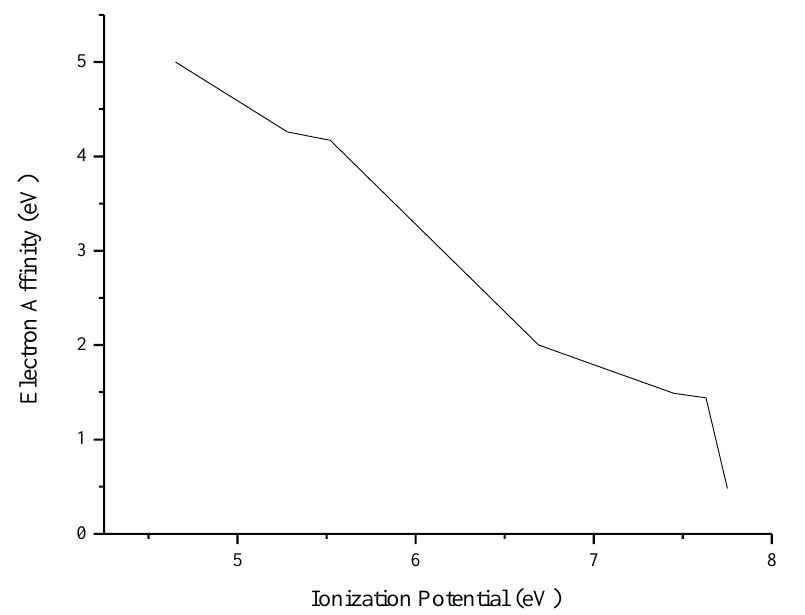
Figure 3. Relationship between ionization potential and electron affinity for the 1,3,4-oxadiazole compounds.